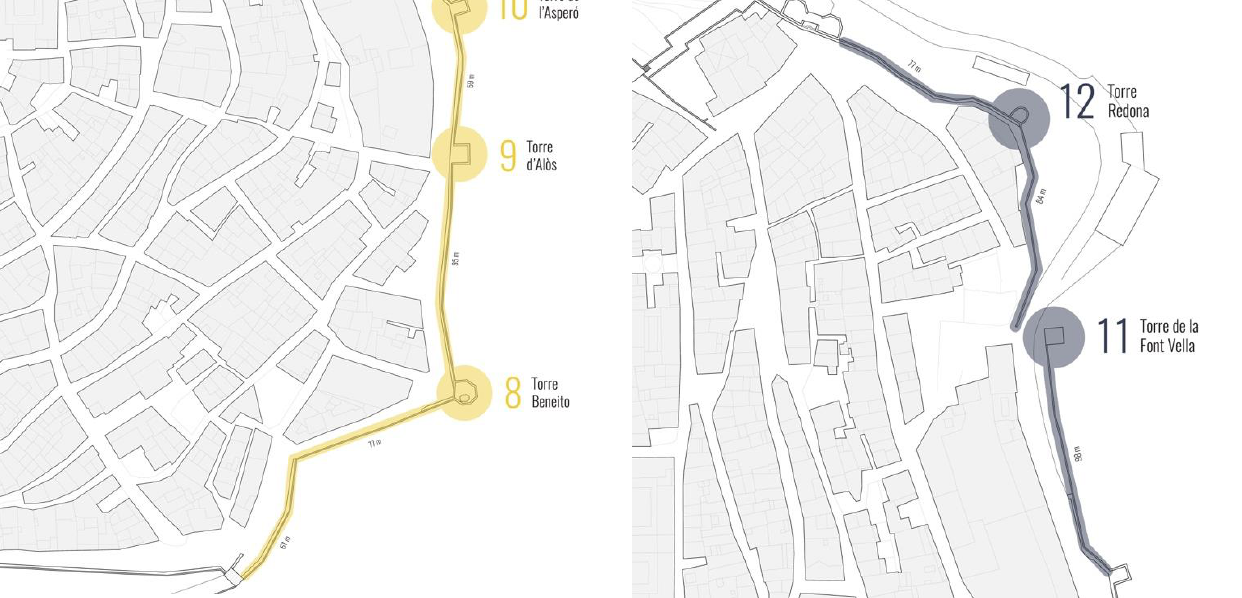
Figure 10. Section III of the “Walls Walking Tour” (Source: Morella Town Council, modified by S. Portela, 2018).